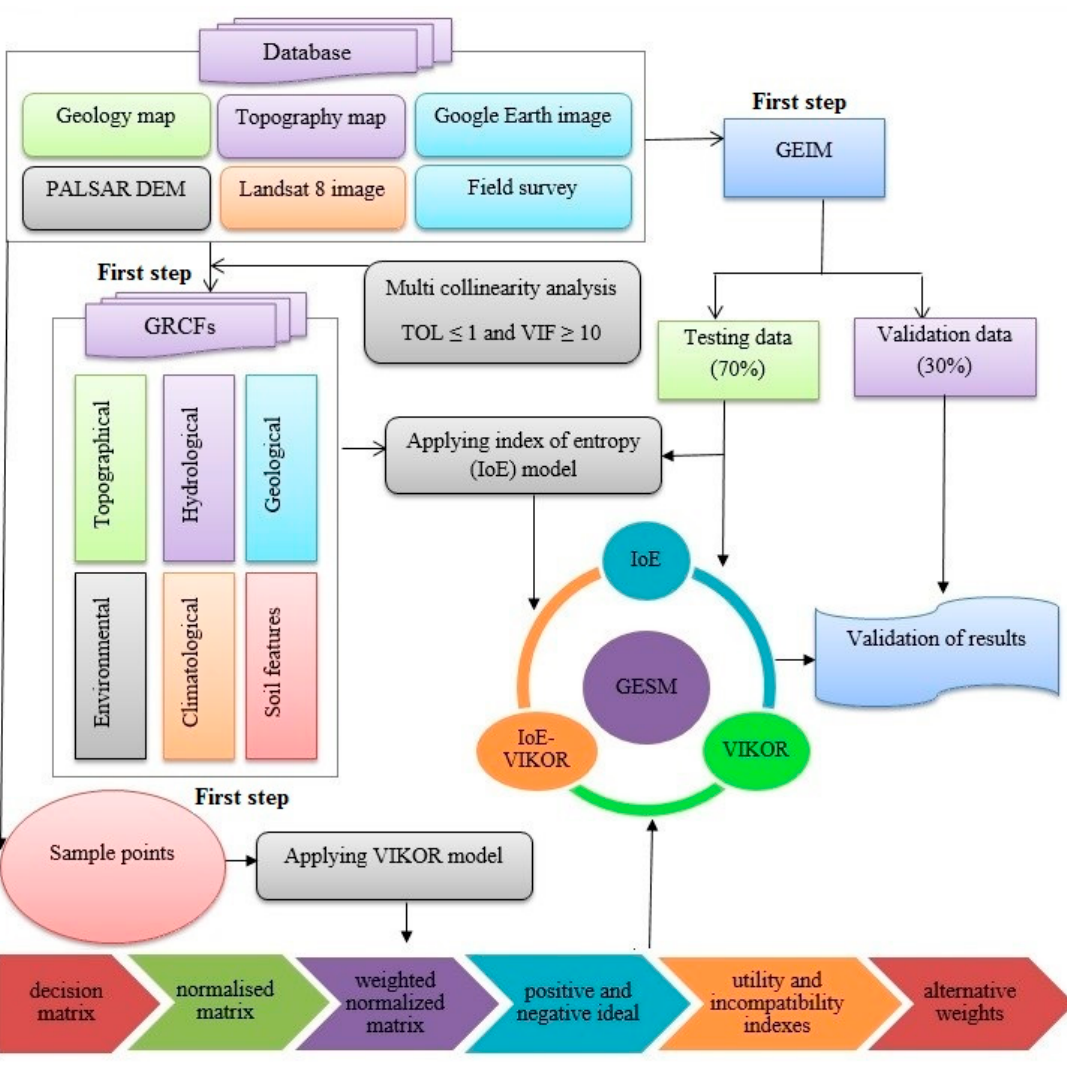
Figure 2. Methodology of research conducted for the study area.